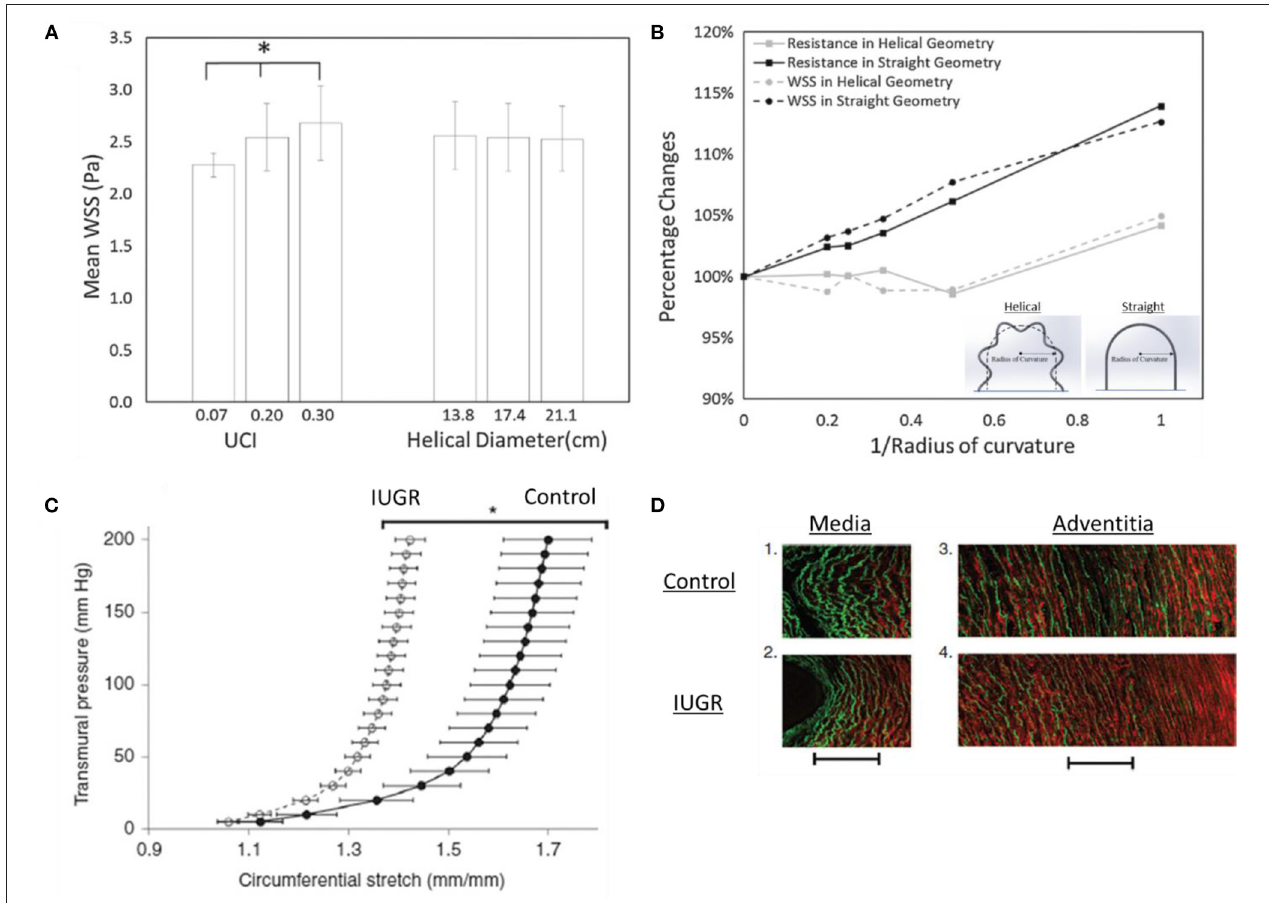
FIGURE 2 | Biomechanics in umbilical arteries. (A) The flow resistance and wall shear stress (WSS) are affected by the umbilical coiling index (UCI) but not helical diameter. (B) Flow resistance and WSS disruption in helical geometry are lesser as compared to straight geometry, suggesting that the helical geometry of umbilical arteries aids in minimizing WSS disruption. This may indicate the existence of the WSS homeostasis mechanism in umbilical arteries for vascular growth ( Saw et al., 2017 ). (C,D) IUGR umbilical arteries stretch lesser compared to control, indicating stiffer properties. The increased stiffness could be due to the increased collagen (red) and decreased elastin (green) contents shown by second-harmonic generation images (Dodson et al., 2013b). * indicates p <